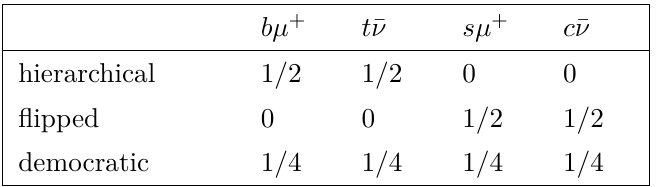
in the benchmark 3